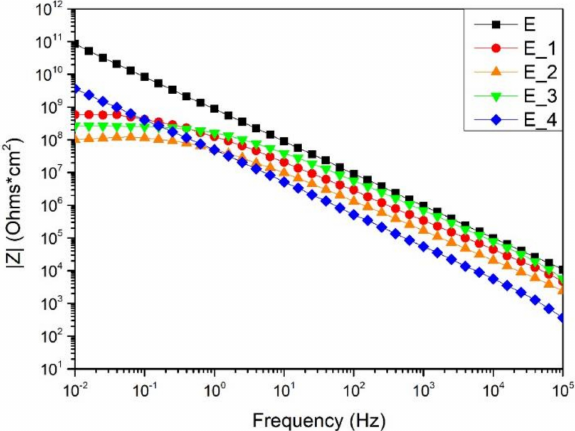
Figure 5. Bode impedance modulus of sample E series before the pack test and after 24 h of exposure in the di ff erent test